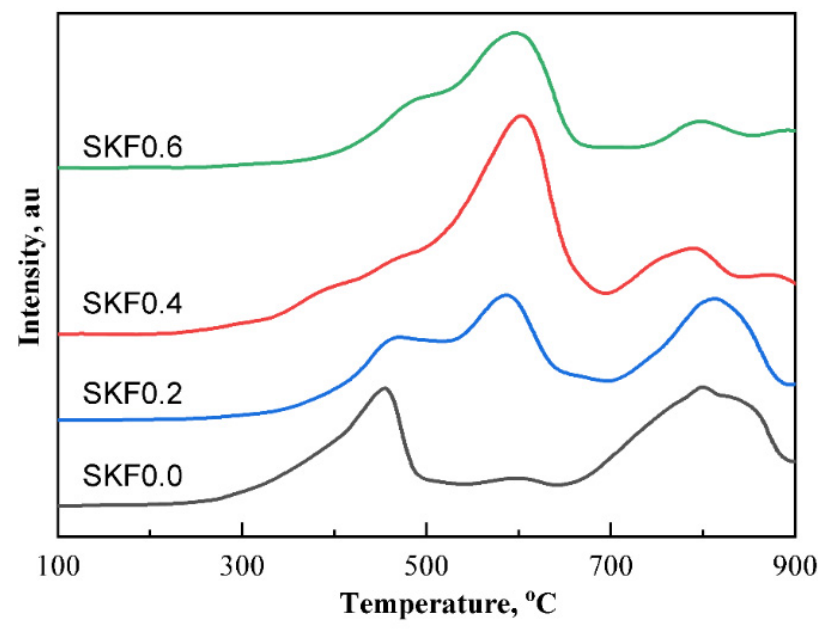
Figure 4. H 2 -TPR profiles of SKFx (x = 0, 0.2, 0.4, 0.6) perovskite catalysts.